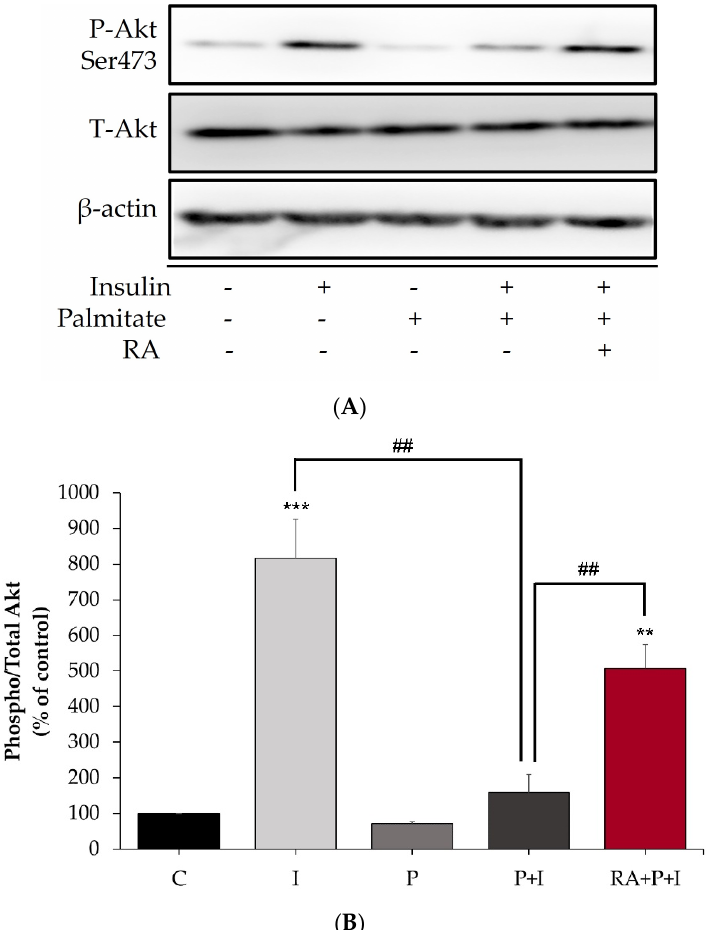
Figure 2. Rosmarinic acid abolishes the deleterious effects of palmitate on insulin-stimulated Akt. Fully differentiated L6 myotubes were treated without (control, C) or with 0.2 mM palmitate (P) for